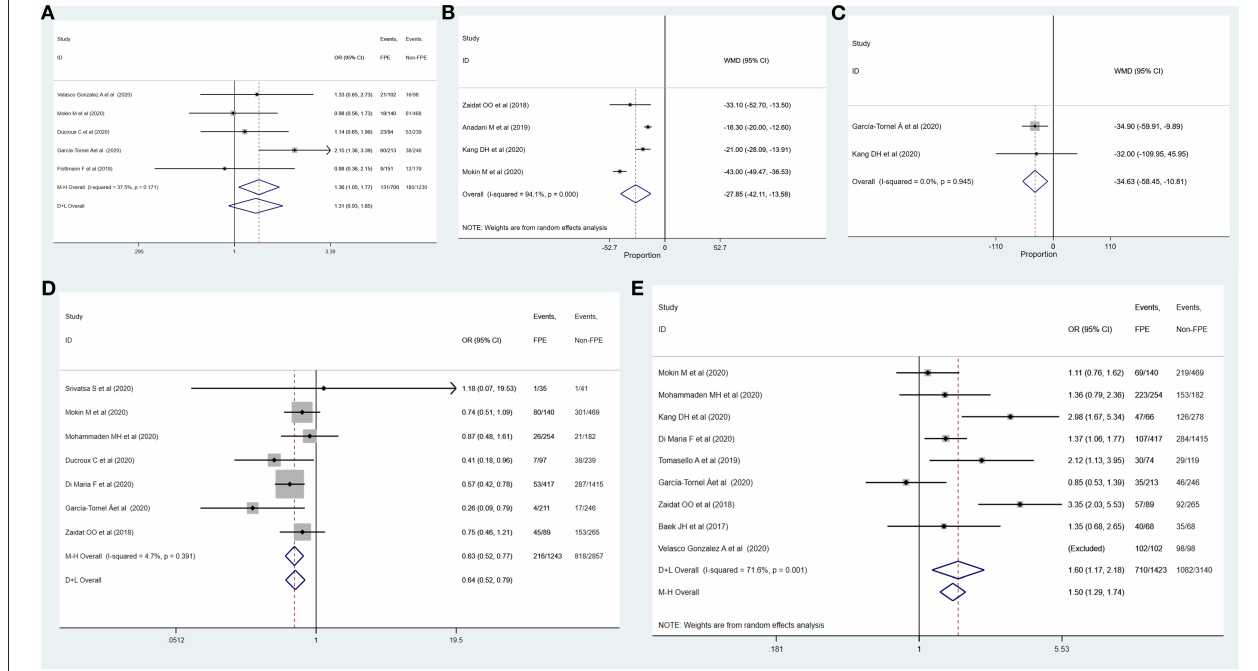
of occlusion, anterior communicating artery (AComA) and posterior communicating artery (PComA) presence, and intervention